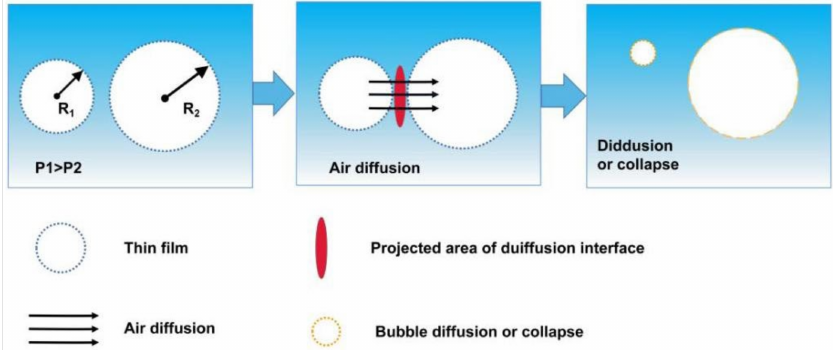
Figure 2. Schematic diagram of gas